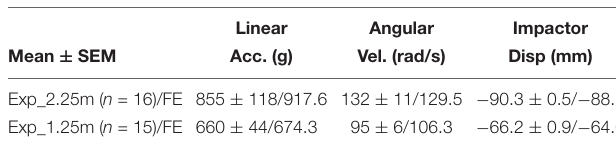
TABLE 5 | FE model head kinematics validated against modified IA experimental